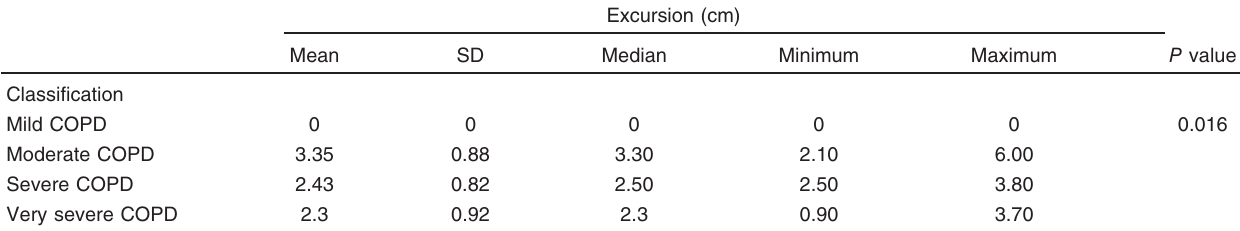
COPD, chronic obstructive pulmonary disease.